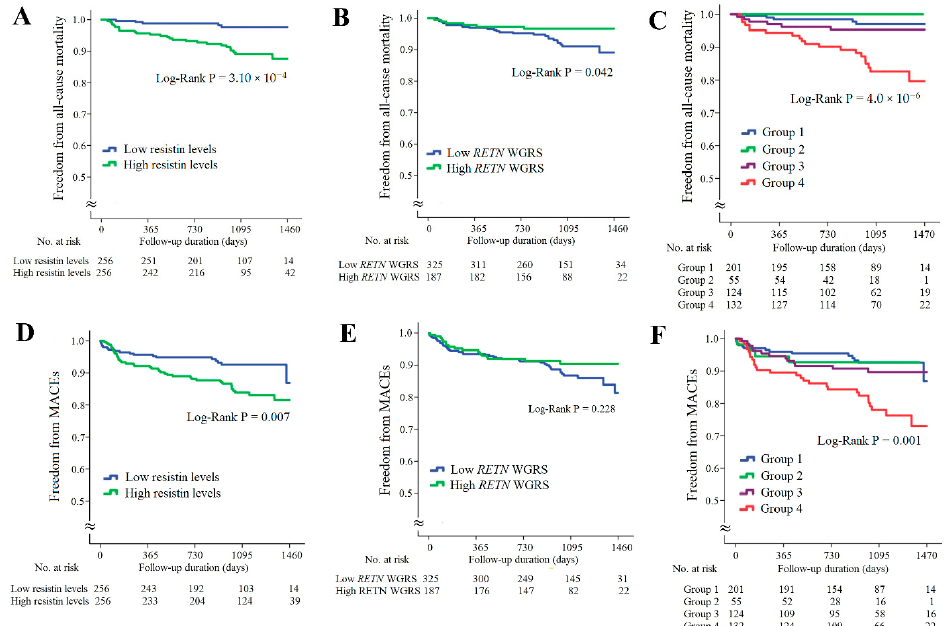
Figure 3. Kaplan–Meier curve analysis of resistin levels and RETN WGRS with long-term outcome in the patients with CAD. ( A – C ) Freedom from all-cause mortality in patients stratified by resistin levels, RETN WGRS, and combination of resistin levels and RETN WGRS. ( D – F ) Freedom from MACEs in patients stratified by resistin levels, RETN WGRS, and combination of resistin levels and RETN WGRS. WGRS, weighted genetic risk scores; MACEs, major adverse cardiac events. Group 1: low resistin levels/low RETN WGRS; Group 2: low resistin levels/high RETN WGRS; Group 3: high resistin levels/high RETN WGRS; Group 4: high resistin levels/low RETN WGRS.